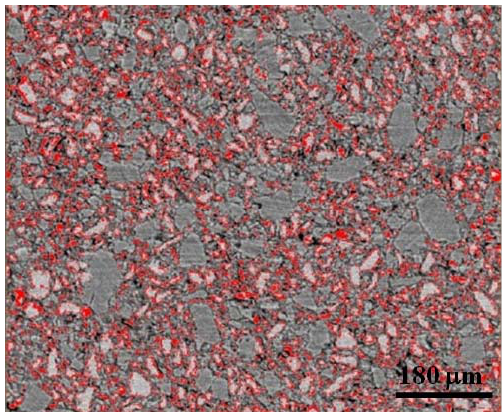
phase in the 4 and MgH for all samples data. 4 2